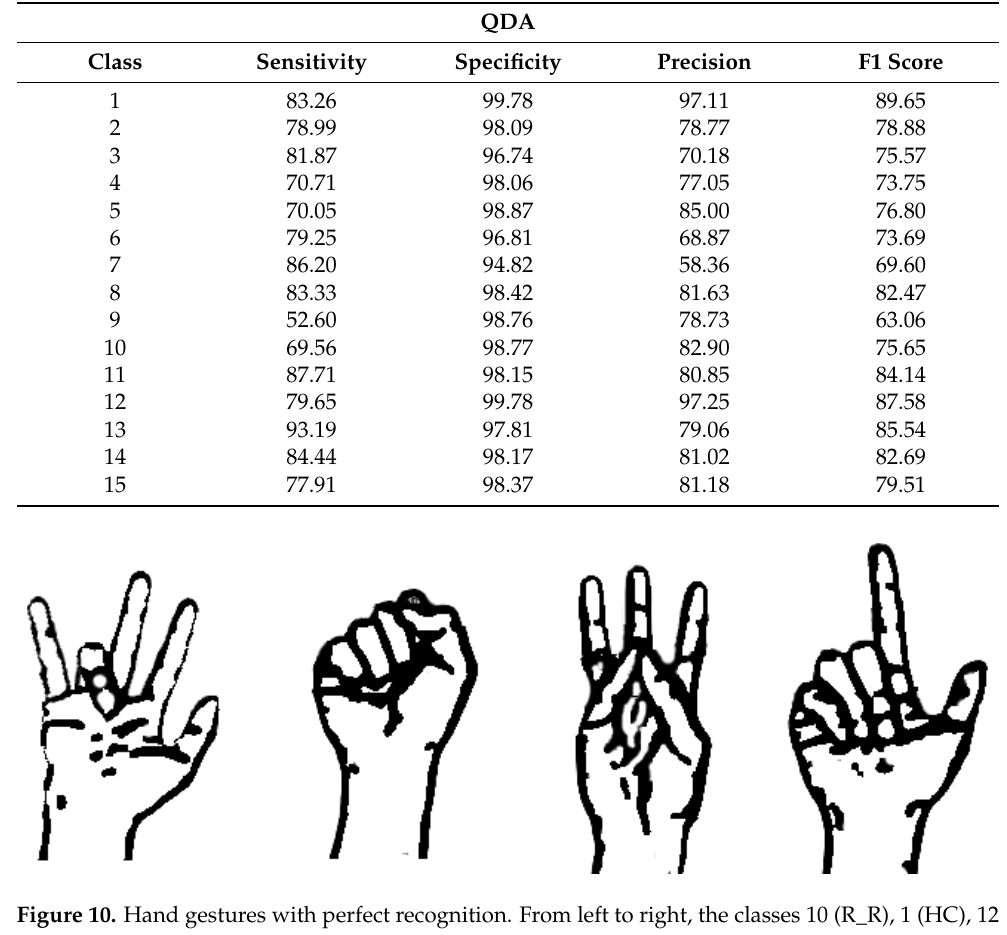
Table 12. Statistical parameters for the dataset formed by the group of eight subjects with 49 electrode features.